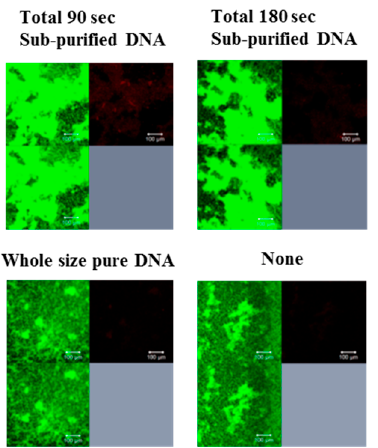
Figure 2. Roles of glucan for biofilm formation of S. mutans by sub-purified DNA. The biofilm formation of S. mutans UA159 gtfBC − induced by sub-purified DNA were analyzed for the production of glucan and observed in media including sucrose . The biofilm formations of S. mutans UA159 gtfBC − were induced by none, sub-purified DNA prepared by beads destruction for total 90 and 180 s, and whole size pure DNA. Their biofilms were stained by SYTO 9 and Alexa Flour 647-dextran conjugate, observed by confocal microscope and analyzed by Zen. Upper left: Live cells, Upper right: Glucan, and Lower left: Live cell merged with glucan were presented. Representative data from more than three independent experiments are presented in the pictures.